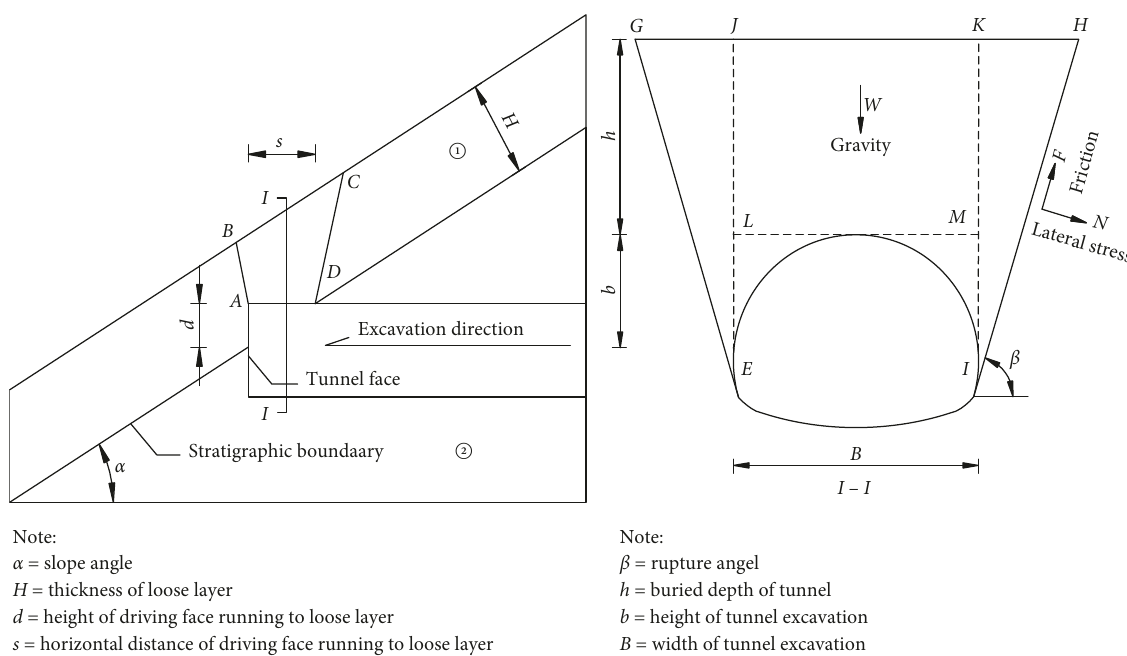
Figure 2: The simplified mechanical